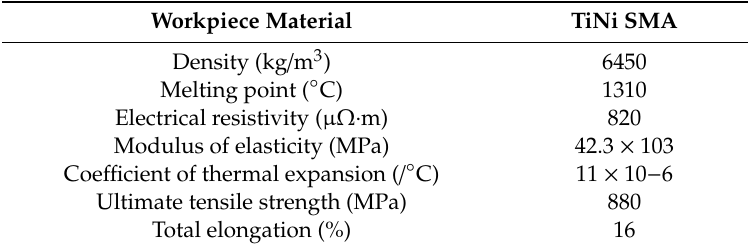
Table 3. Physical and mechanical properties of the TiNi shape memory alloy (SMA).